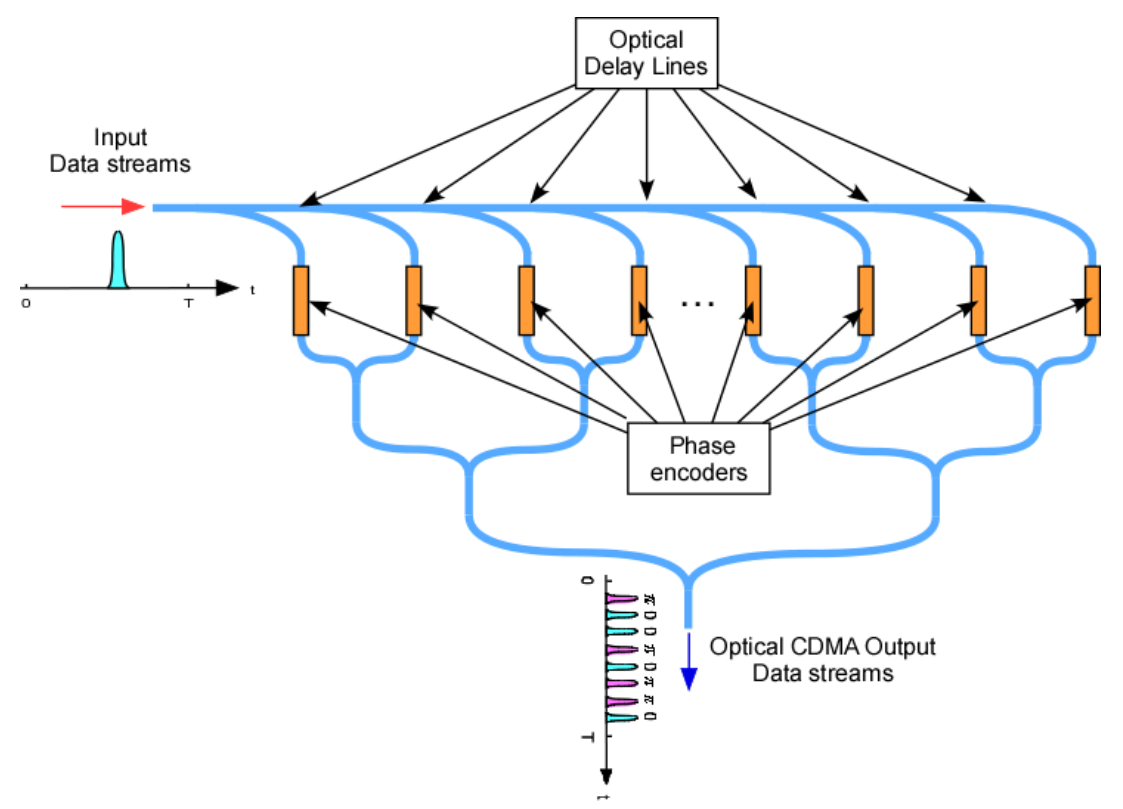
Figure 1. Schematic structure of the proposed optical Code-Division Multiple-Access (CDMA) encoder. It consists of ten 10% tap couplers, optical time-delay lines, and phase-encoders. Each of the time-delay lines is designed to provide a 5 ps time-delay. The time-delayed data streams are phase-encoded by the integrated phase-encoders. The phase-encoded data streams are finally combined and sent out through the optical CDMA output